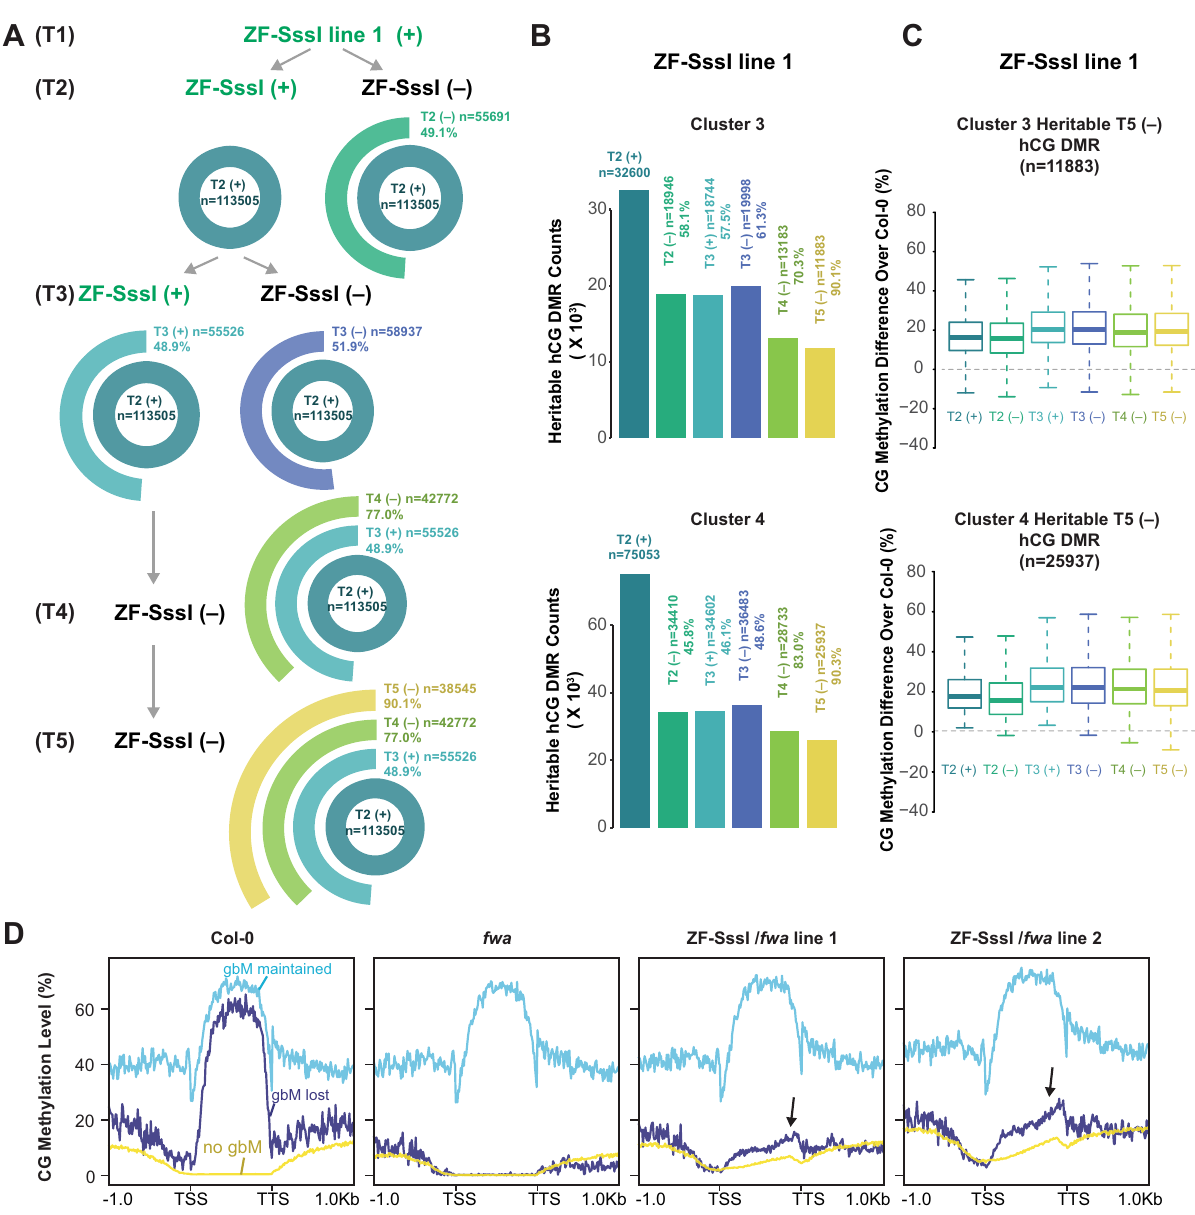
Fig. 6 Targeted CG methylation is heritable. A Multilevel pie chart of the number of heritable hyper CG DMRs in ZF-SssI line 1 during T2, T3, T4, and T5 (( + ) indicates ZF-SssI lines containing the transgene, which could be homozygous or heterozygous in the indicated generation; ( ‒ ) indicates plants without the transgene in the indicated generation). B Barplot for the number of heritable hyper CG DMRs over Clusters 3 and 4 in ZF-SssI line 1 during T2, T3, T4, and T5. For the percentage of heritable hyper CG DMRs T2 ( ‒ ), T3 ( + ), and T3 ( ‒ ) are compared with T2 ( + ); T4 ( ‒ ) is compared with T3 ( + ); T5 ( ‒ ) is compared with T4 ( ‒ ). C Boxplot of CG methylation difference level of ZF-SssI during T2 to T5 over Col-0 in Clusters 3, and 4 heritable hyper CG DMRs in ZF-SssI line 1 ( ‒ ) during T5. The middle line shows the median; boxes represent the 25th (bottom) and 75th (top) percentiles; and bars represent the minimum and maximum points within the 1.5× interquartile range. D Metaplot of CG methylation in Col-0, fwa , and two ZF-SssI lines in the fwa background over ‘ no gbM ’ , ‘ gbM lost ’ , and ‘ gbM maintained ’ protein-coding genes. ‘ no gbM ’ represents genes with no gbM in fwa and Col-0; ‘ gbM lost ’ represents genes that lost gbM in fwa compared with Col-0; ‘ gbM maintained ’ represents genes that maintained gbM in fwa compared to Col-0. The black arrow indicates the hCG in ZF-SssI/ fwa lines over genes that had lost gbM in fwa gbM (genes with less than 1% CG gbM in Col-0 and fwa ), genes